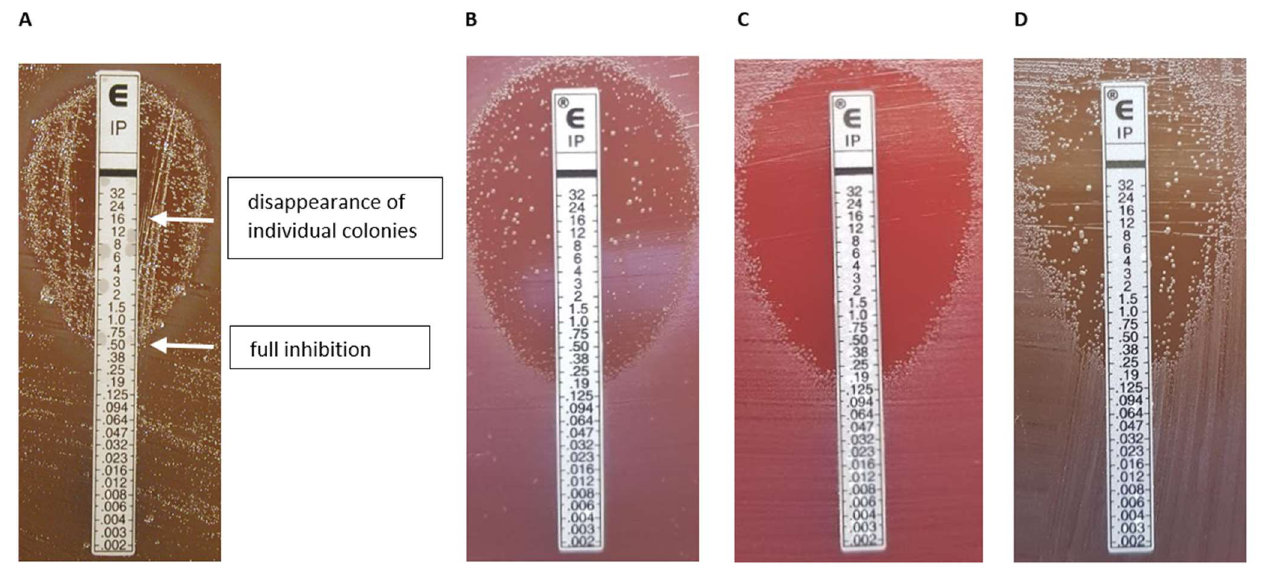
Figure 2. Etest HR phenotypes. A typical Etest phenotype ( B. fragilis 16997) [8] showing the reading annotation; in this example 0.5–(16), the first value expresses the inhibition of full growth, then after a dash, the value indicates in parenthesis where the inside colonies disappeared. ( A ). The ‘inheritance’ of the Etest HR phenotype ( B – D ). Original appearance ( B ); an inner colony direct Etest ( C ); an Etest result of an inner colony after an intermediate cultivation on a Columbia blood agar ( D ).